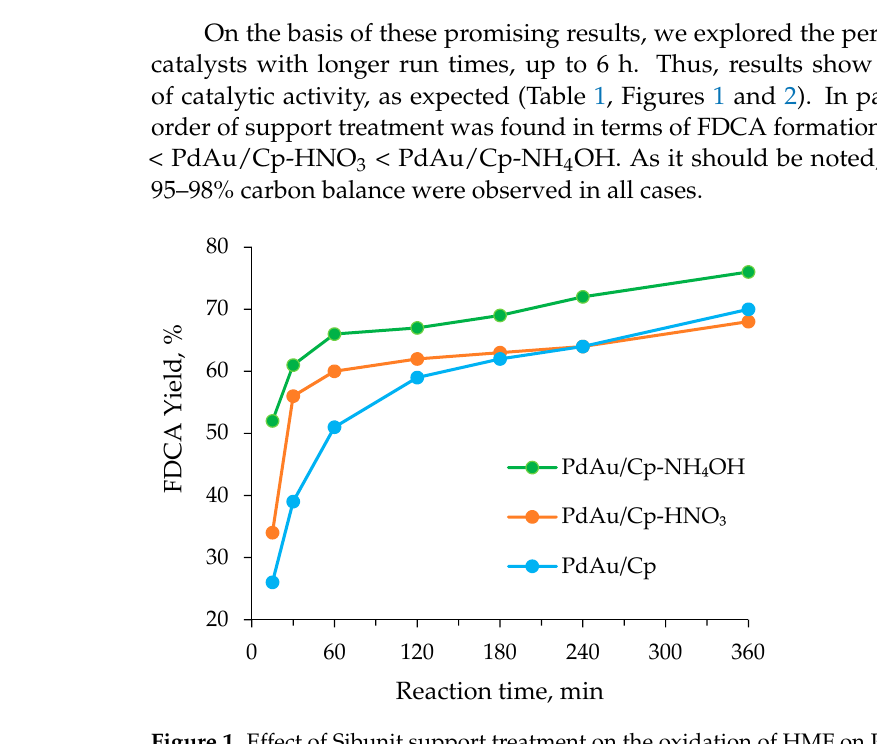
Figure 1. Effect of Sibunit support treatment on the oxidation of HMF on Pd-Au catalysts: evolution of FDCA yield with run time. Reaction conditions: 0.15 M HMF (H ₂ O, 0.15 L), NaOH/HMF = 2 equiv., T = 60 °C, p(O 2 ) 3 atm, R = 200.